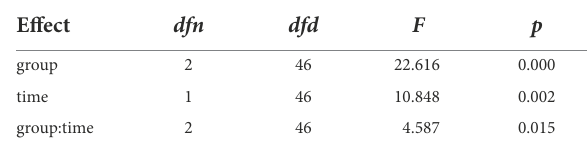
TABLE 4 Overall repeated measures ANOVA.